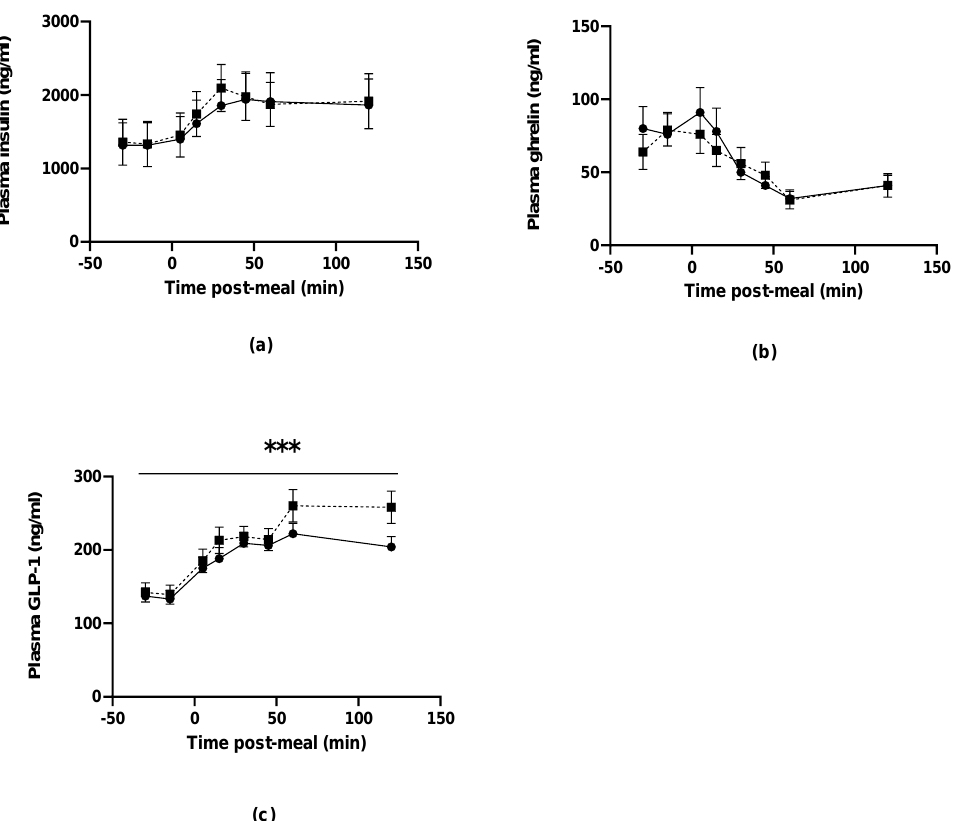
Figure 4. Plasma concentrations of ( a ) Insulin, ( b ) Ghrelin and ( c ) GLP-1 before and after consumption of the pasta lunch meal prepared with plant-based (closed circles and solid lines) and beef (closed squares and dotted lines) mince. There were no differences in the concentrations of insulin or GLP-1 between the plant-based and beef mince meals either before or after consumption, whereas GLP-1 concentrations were lower following the consumption of the plant-based mince compared to the beef mince (***, repeated measures ANOVA, F = 3.91; p < 0.001).